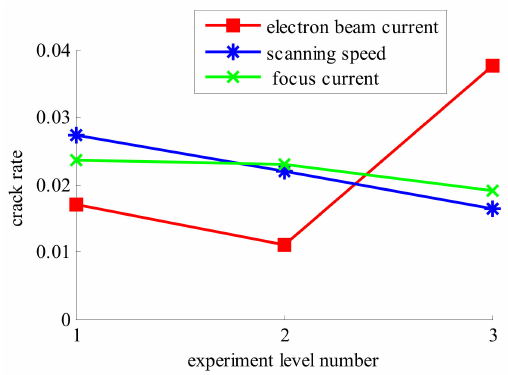
Figure 3. The influence of various factors on the R -value of the crack areal